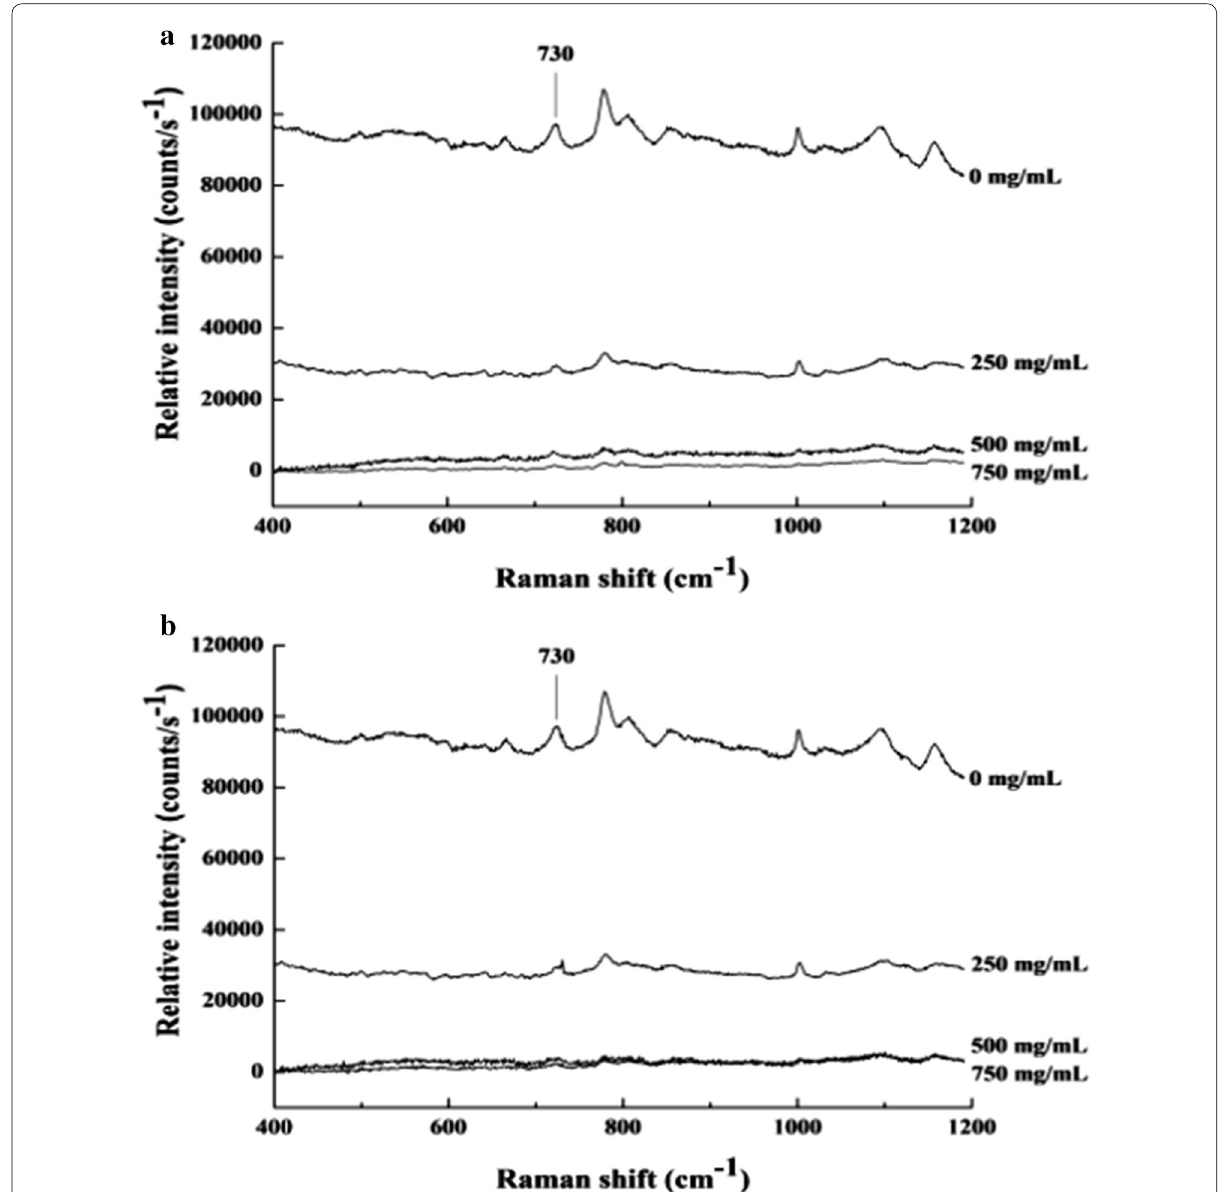
Fig. 3 Effect of ε-PL on the cell wall of S. aureus by Raman spectroscopy. a 2 h; b 4